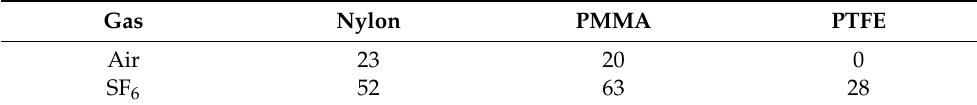
Table 3. Percent of surface path along different materials in air and SF 6